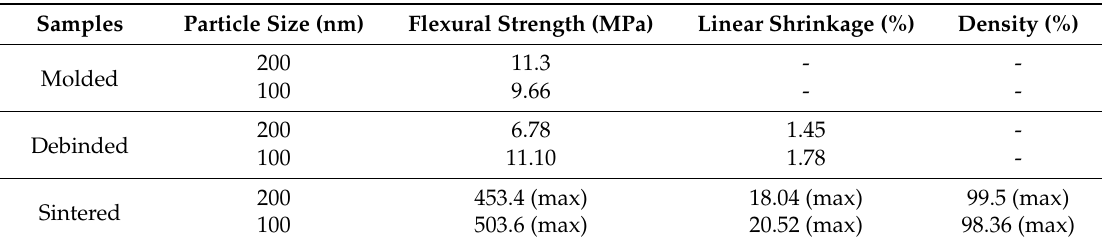
Table 4. Comparison of injection, debinding and sintering properties with the different powders.